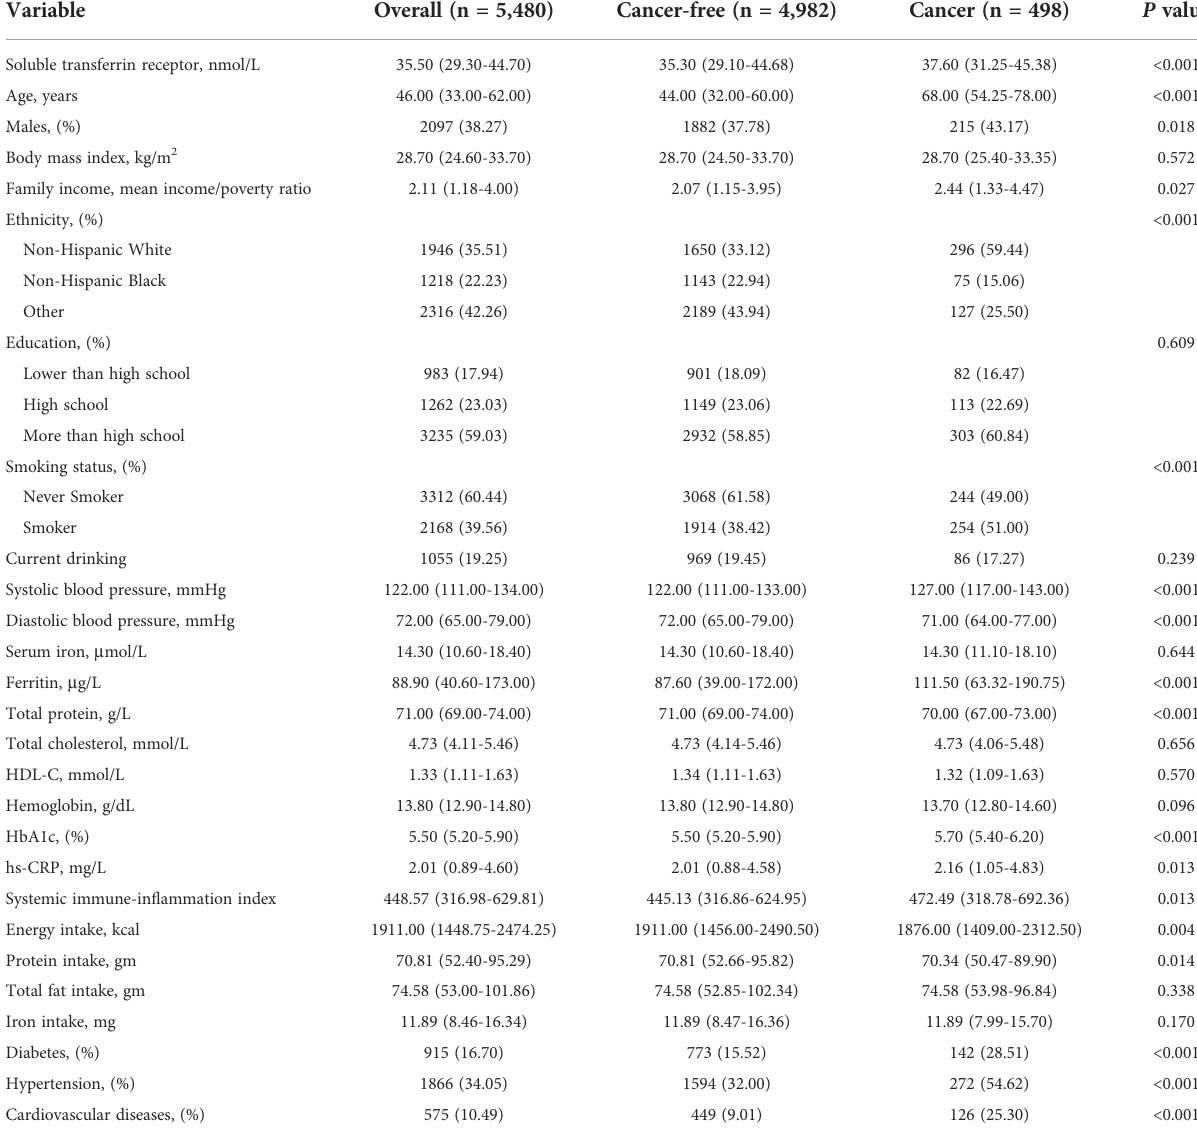
TABLE 1 Baseline characteristics of NHANES participants included in this study a